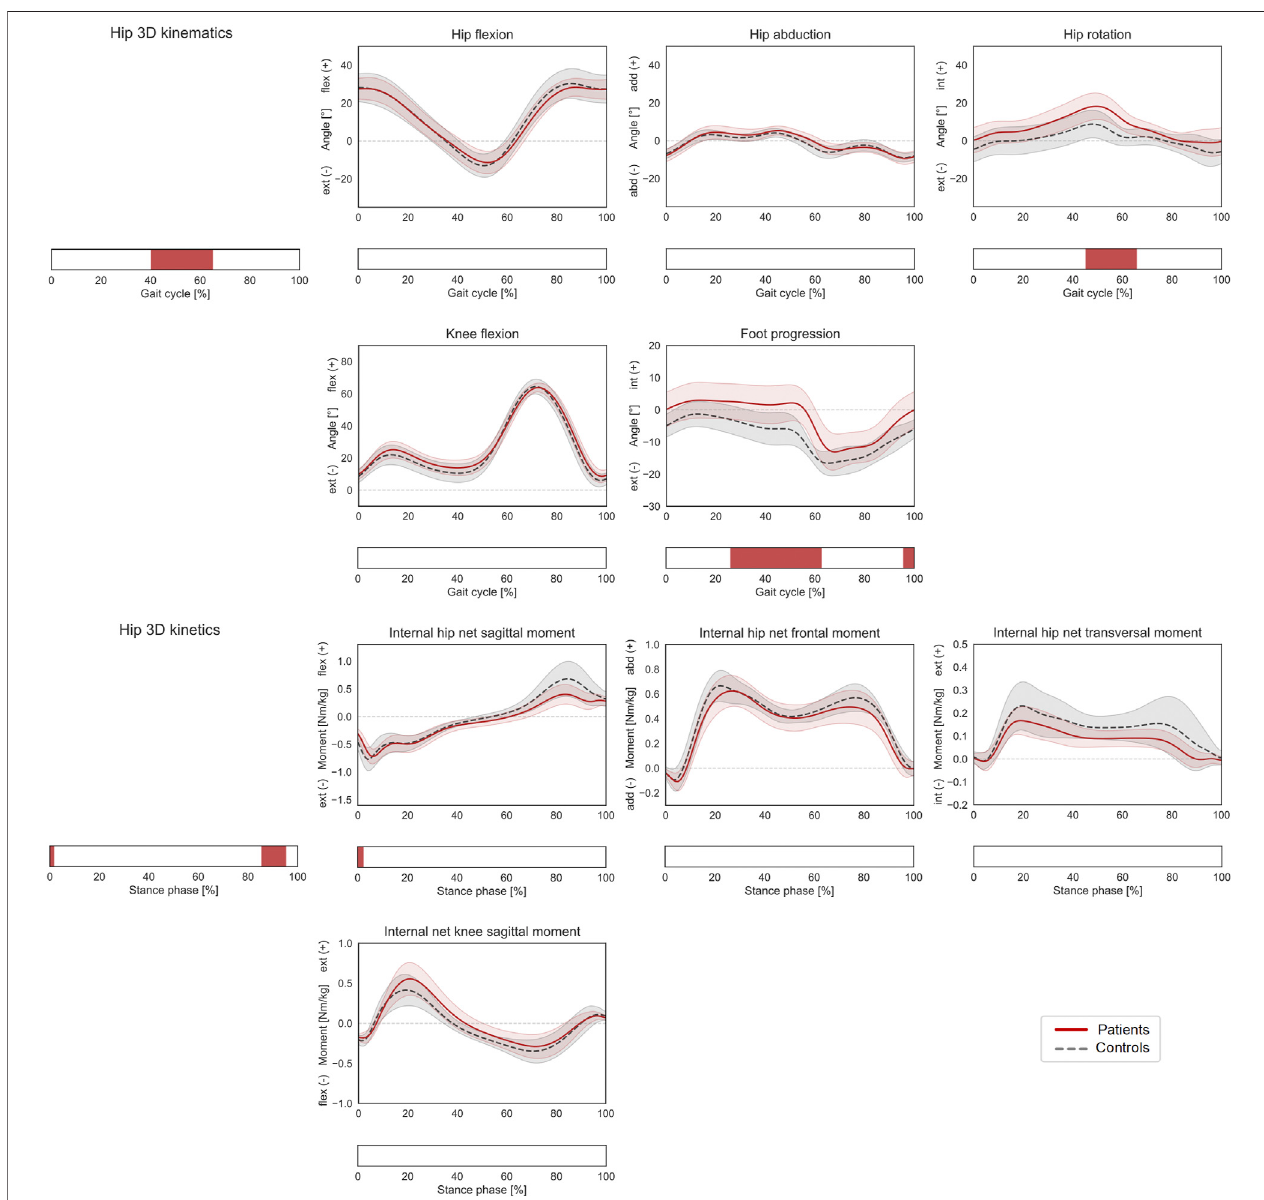
FIGURE2| Lower-limbkinematicsduringthegaitcycle(GC)andjointmomentsduringstancephase(ST).Mean±1SDhip fl exion,hipabduction,hiprotation,knee fl exion,andfootprogressionangles,aswellashipsagittal,frontal,transversal,andkneesagittalmoments,arereportedasredsolidlinesforpatients,andasgreydashed lines for controls. Intervals of GC or ST with a statistically signi fi cant difference in the relevant SPM tests are reported as red bars. Hip joint angles and moments were regarded as a 3D vector fi elds. 3-dimensional signi fi cant differences between patients and controls were analyzed by means of two-sample Hotelling T2 tests and arereportedintheleftmostpanels.1Dscalaroutcomevariables,aswellasindividualcomponentsofthevector fi eldsinthepost-hocvectorialanalyses,wereanalyzedby means of two-sample t-tests and intervals characterized by signi fi cant differences between the two groups are reported below each subplot.